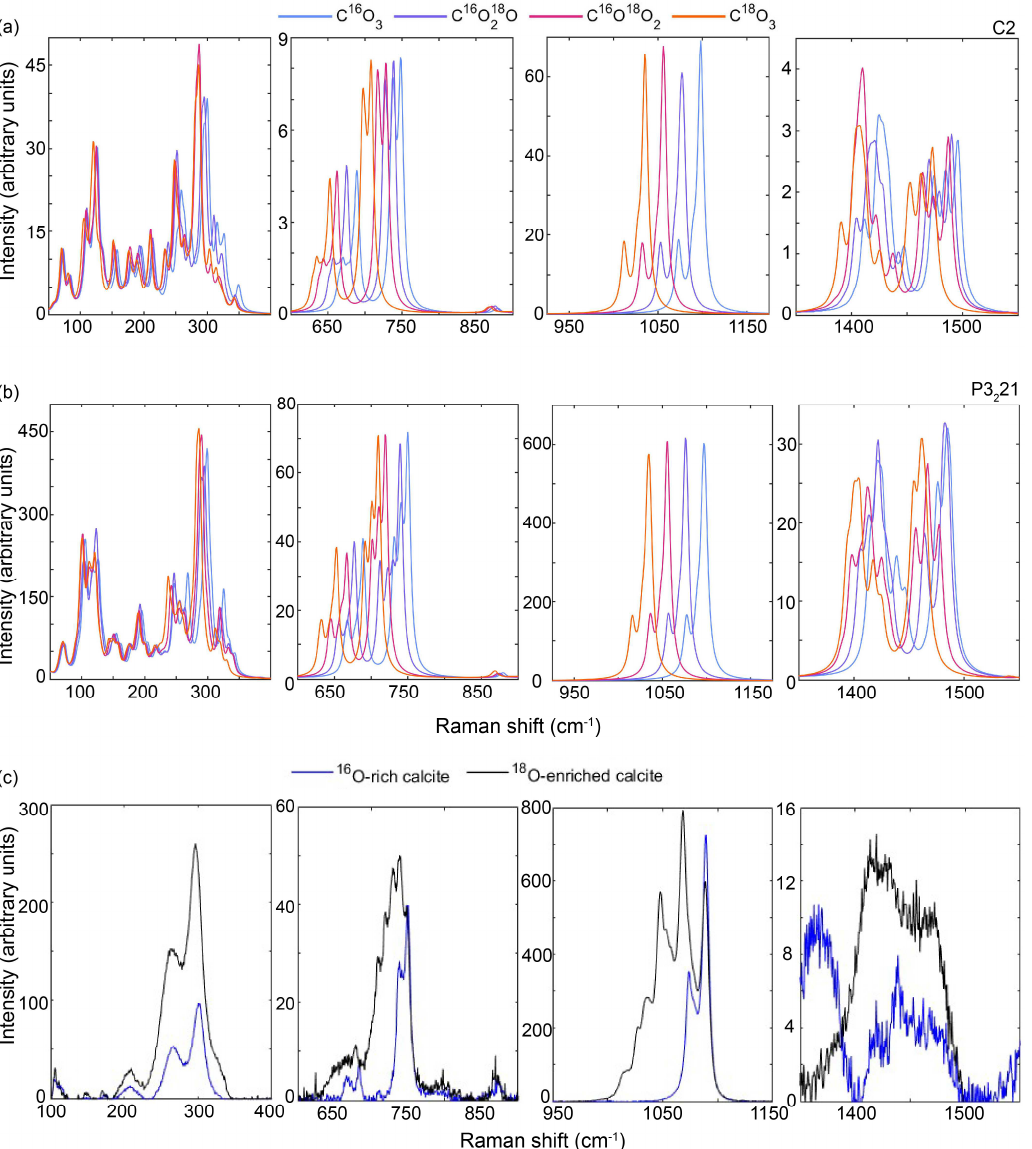
Figure 3. Calculated Raman spectrum of vaterite with each of the four carbonate O − isotopologues: ( a ) C2 structure, ( b ) P3 2 21 structure, ( c ) experimentally determined Raman spectrum for a single vaterite crystal. The regions outside of the plotted areas have no vibrational bands visible. Note that the individual regions of interest are plotted with different y axes to facilitate visualization. Isotopic substitution resulted in new bands clearly emerging from the band envelope between 1000 and 1100 cm −1 in the experimental Raman spectrum (Figure 1c, Table S1). In the calculated spectra, the most intense and sharpest bands visible in this envelope at 1048 and 1068 cm −1 fit the shifts of the υ 1 symmetric stretching mode, at 1089 cm −1 for the C 16 O 3 isotopologue, estimated based on a harmonic oscillator assumption and the reduced mass of the partially substituted isotopologues and that found in our DFT calculations. The broadening of the entire band envelope in the substituted experimental samples thus oc- curred due to similar isotope-related splitting of the other υ 1 symmetric stretching mode